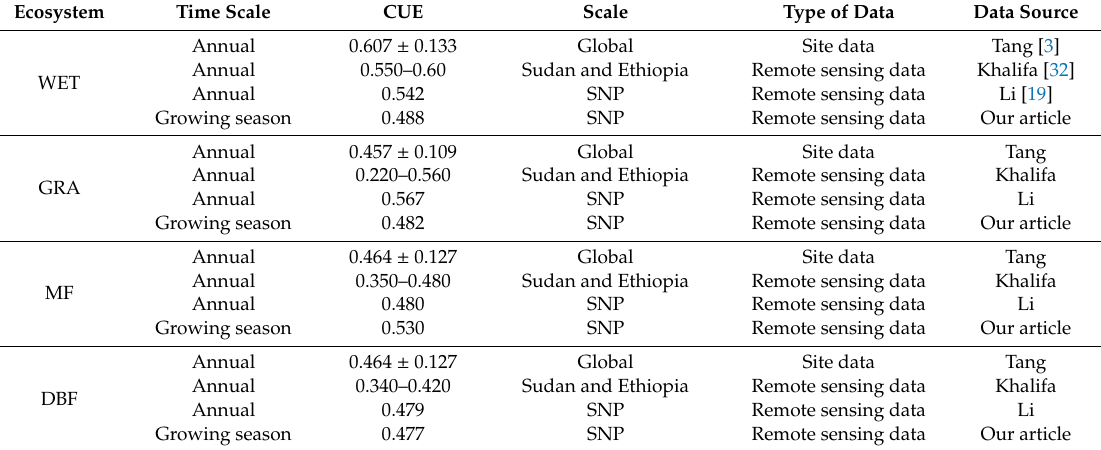
Table 4. Comparison of estimated CUE at di ff erent time scales in di ff erent